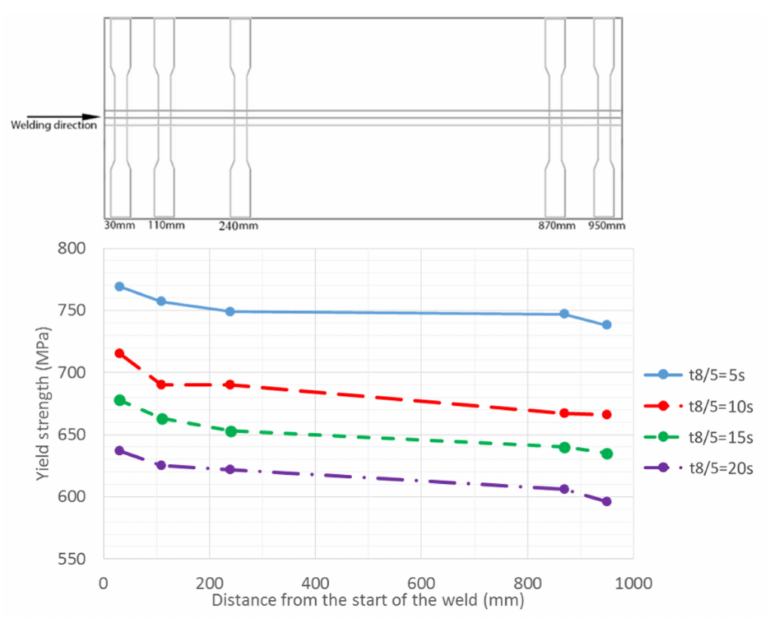
Figure 7. The effect of the distance from the start of the weld on tensile test properties in the S700MC-1. The distance is measured to the center of the tensile specimen.